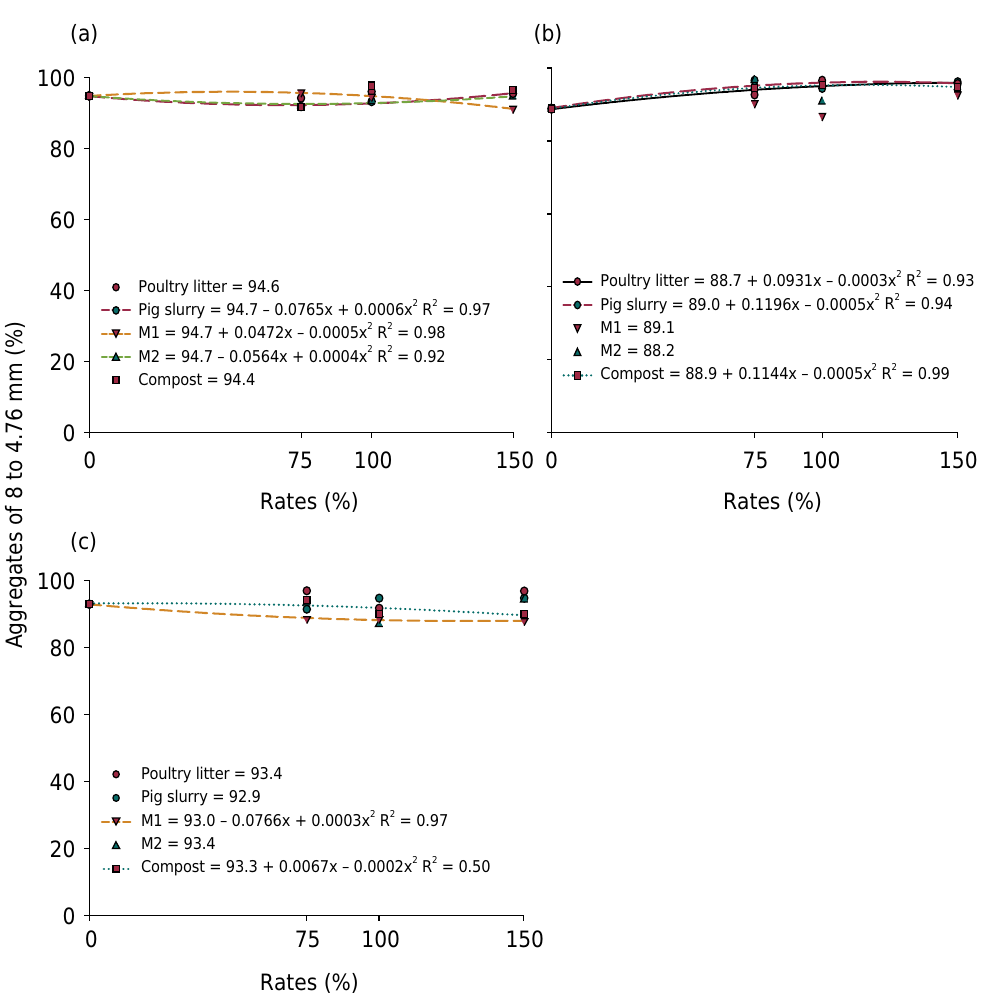
Figure 3. Aggregates of the class (C1 = 8 to 4.76 mm) in the Rhodic Kandiudox, in the layers after seven years of application of different types and rates (%) of organic and mineral fertilizers. (a) 0.00-0.05 m soil layer; (b) 0.05-0.10 m soil layer; and (c) 0.10-0.20 m soil layer. M1: mineral fertilizer 1, equivalent to pig slurry; M2: mineral fertilizer 2, equivalent to poultry